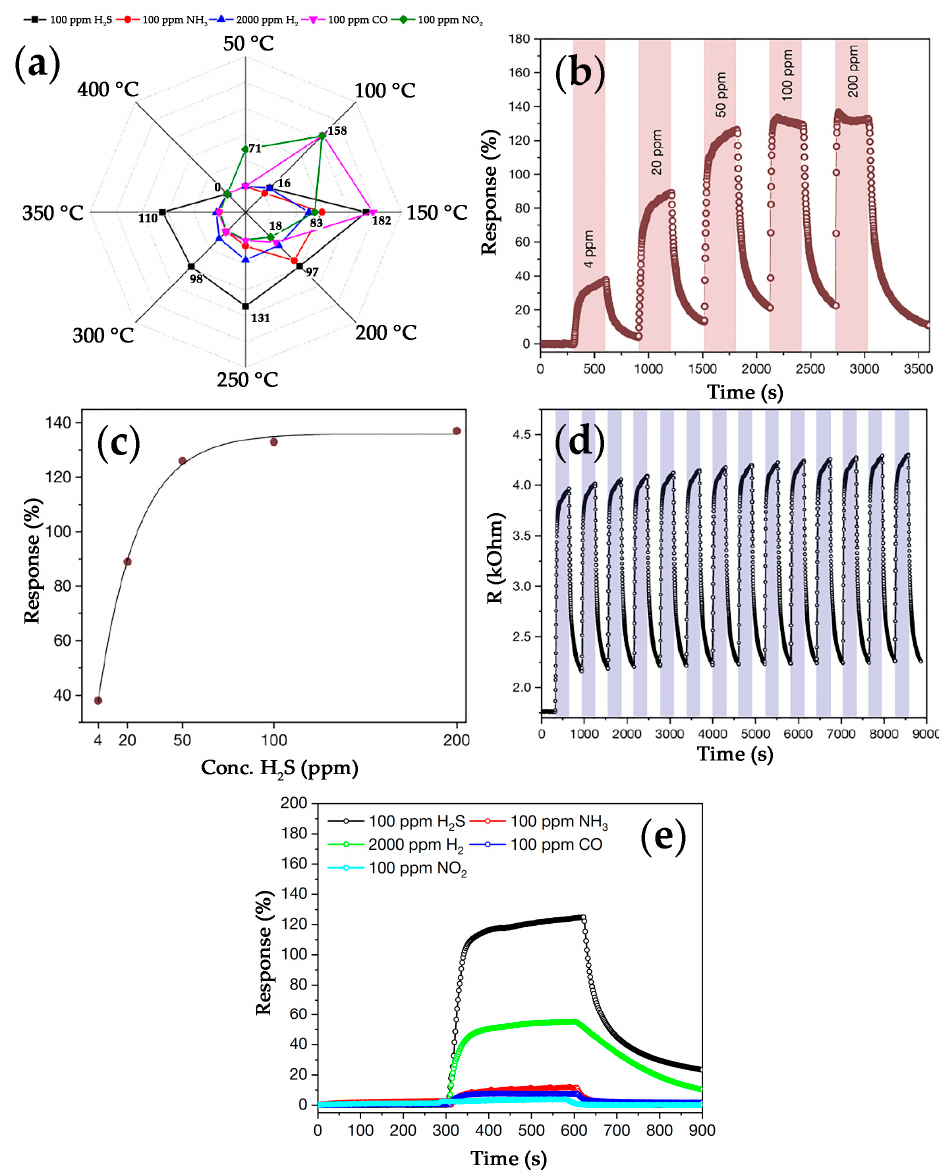
Figure 9. Selectivity diagram showing responses to 100 ppm H 2 S, NH 3 , CO, NO 2 и 2000 ppm H 2 at different operating temperatures with numerical values of sensor response to H 2 S and NO 2 ( a ), signal reproducibility upon detecting 50 ppm H 2 S at 250 ° С ( b ), experimental data upon detecting 4–200 ppm H 2 S at 250 ° С ( c ), dependence of sensor response value on H 2 S concentration at 250 ° С ( d ) and the sensor response shape when detecting the analytes under study at 250 °C ( e ).